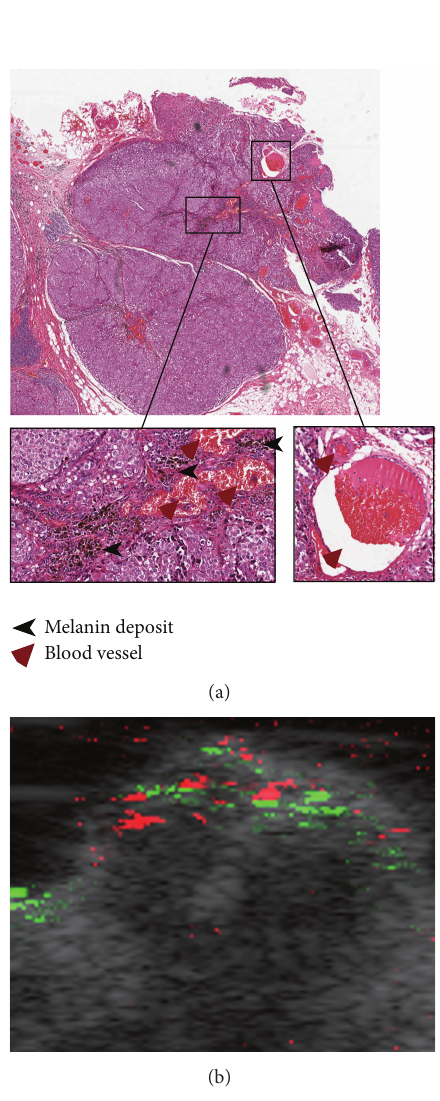
Figure 4: Pathology slide (a) and photoacoustic image (b) image of a second tumor-positive lymph node (node 11 from Table 1). This node has more blood vessels and less melanin deposits compared to the node in Figure 3. Blood vessels and melanin in the upper part of the node are more